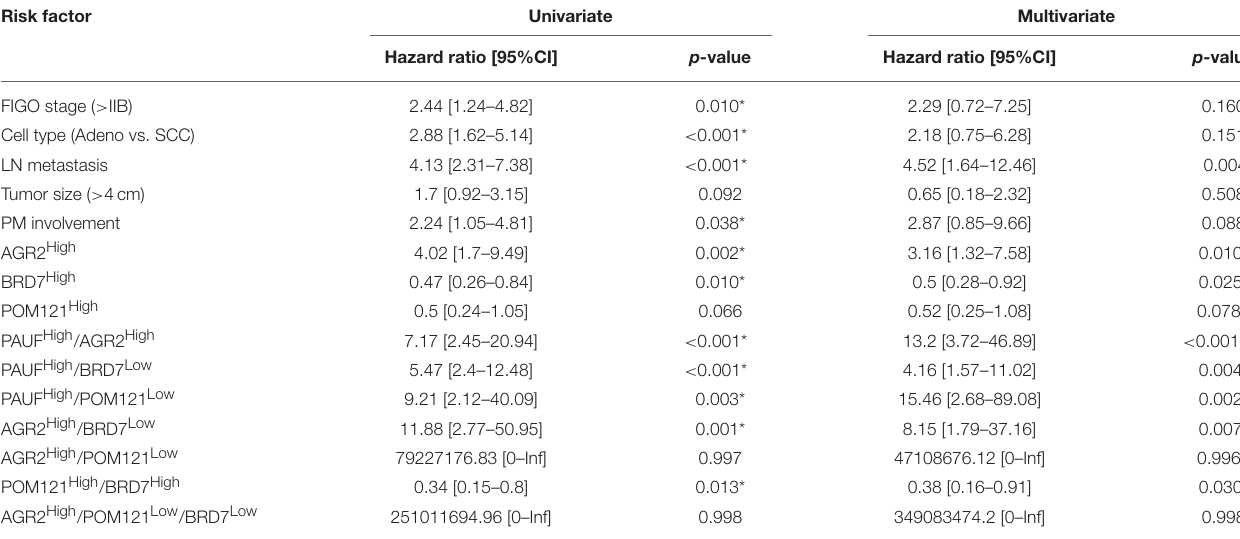
FIGO, International Federation of Gynecology and Obstetrics; SCC, squamous cell carcinoma; AC, adenocarcinoma; LN, lymph node; PM, parametrium. * Significant at the level of p < 0.05.